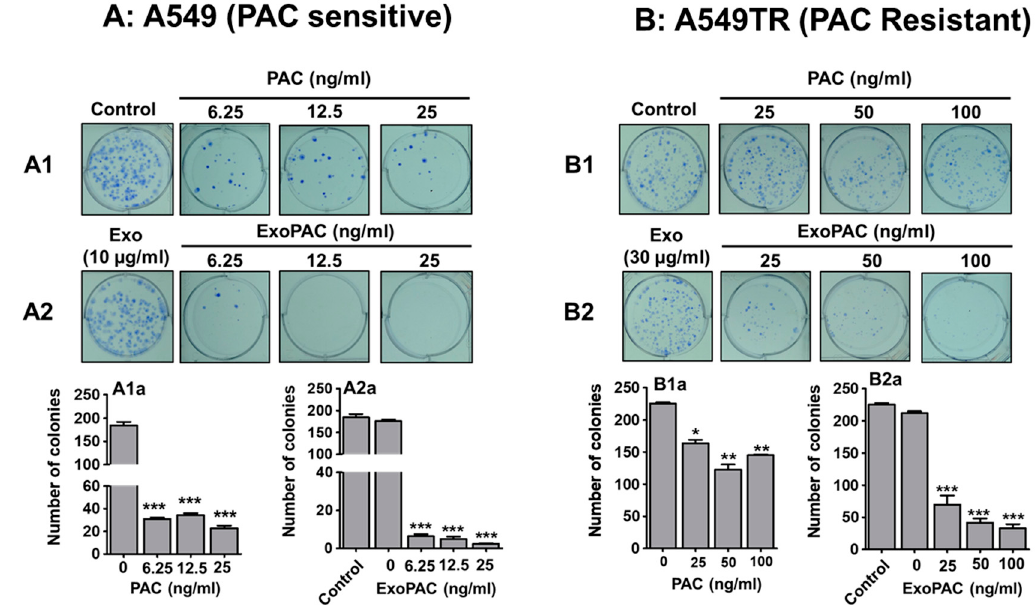
Figure 3. Exosomal PAC inhibited colony formation in NSCLC cells. Representative images showing the colony formation assay in drug-sensitive A549 ( A ) and drug-resistant A549TR ( B ) cells. Lung cancer cells were seeded (500 cells/well) in a six-well plate and incubated with different concentrations of PAC and ExoPAC. After 10 days, developed colonies were fixed, stained and counted manually. While PAC was effective, only against drug-sensitive cells ( A1 , B1 ), ExoPAC shows dose-dependent inhibition of colony formation of both sensitive and resistant cells ( A2 , B2 ). Statistical analysis was performed using the Student’s t -test. *, p < 0.05; **, p < 0.01; ***, p < 0.001.